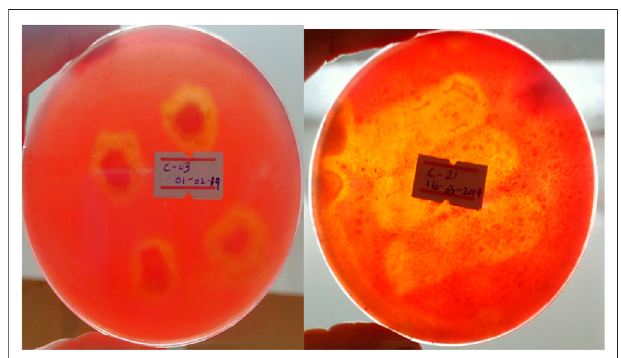
FIGURE 1 | The detection of cellulase activity of the tested strains C-03 and